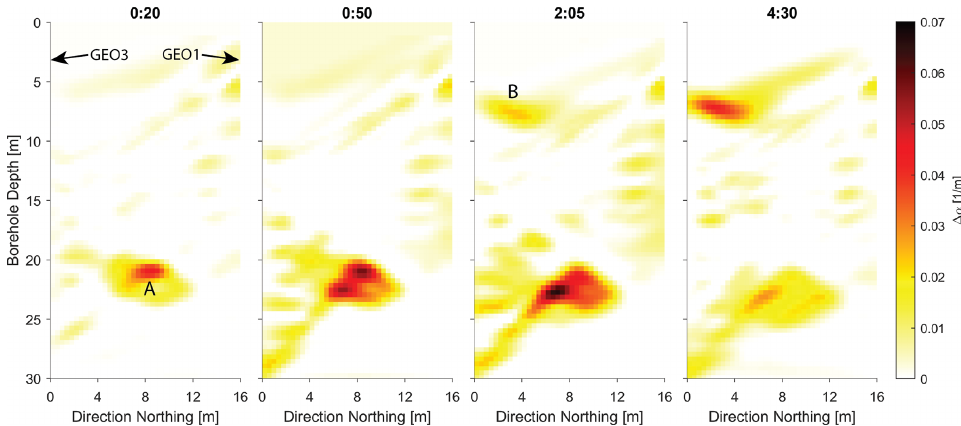
Figure 8. Results of the difference attenuation tomography for different time steps after tracer injection. The tracer-induced rise in attenuation can be seen early around a borehole depth of 22m (labeled A) and later at around 8m (labeled B).